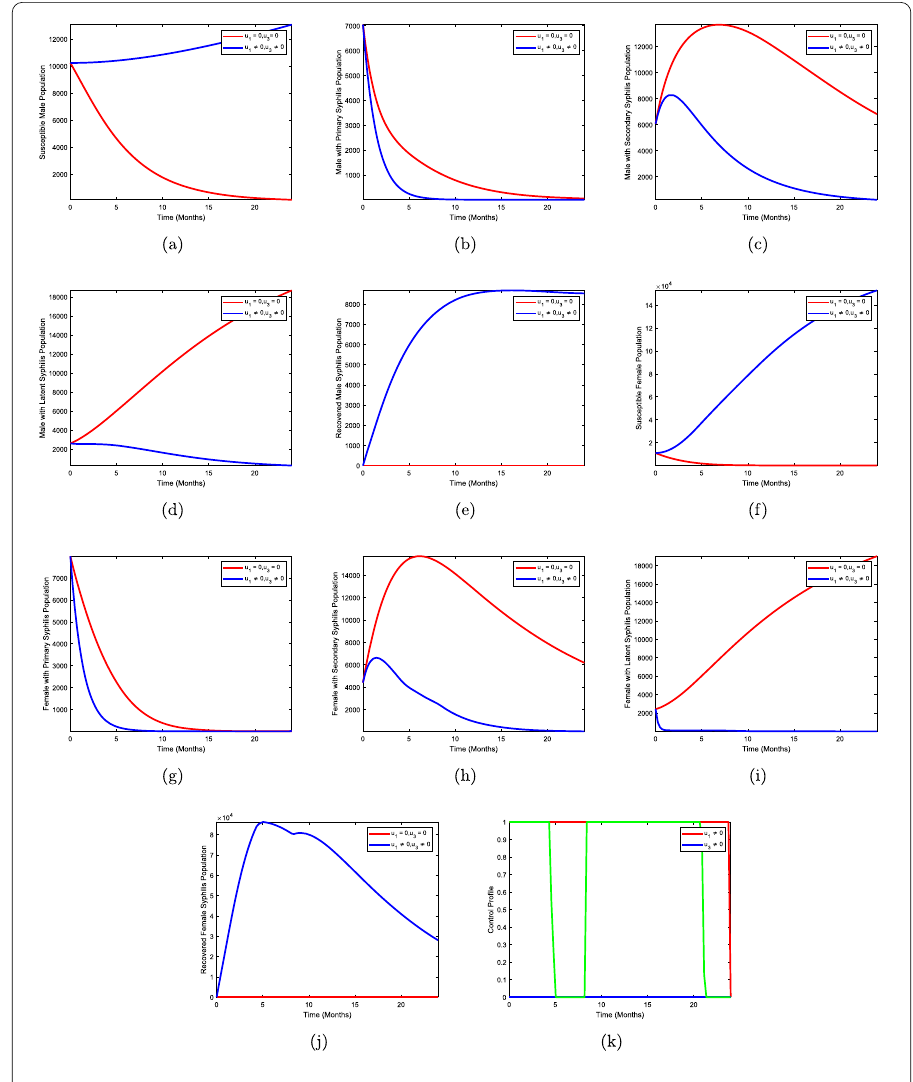
Figure 3 Use of condom + treatment of female with syphilis infection